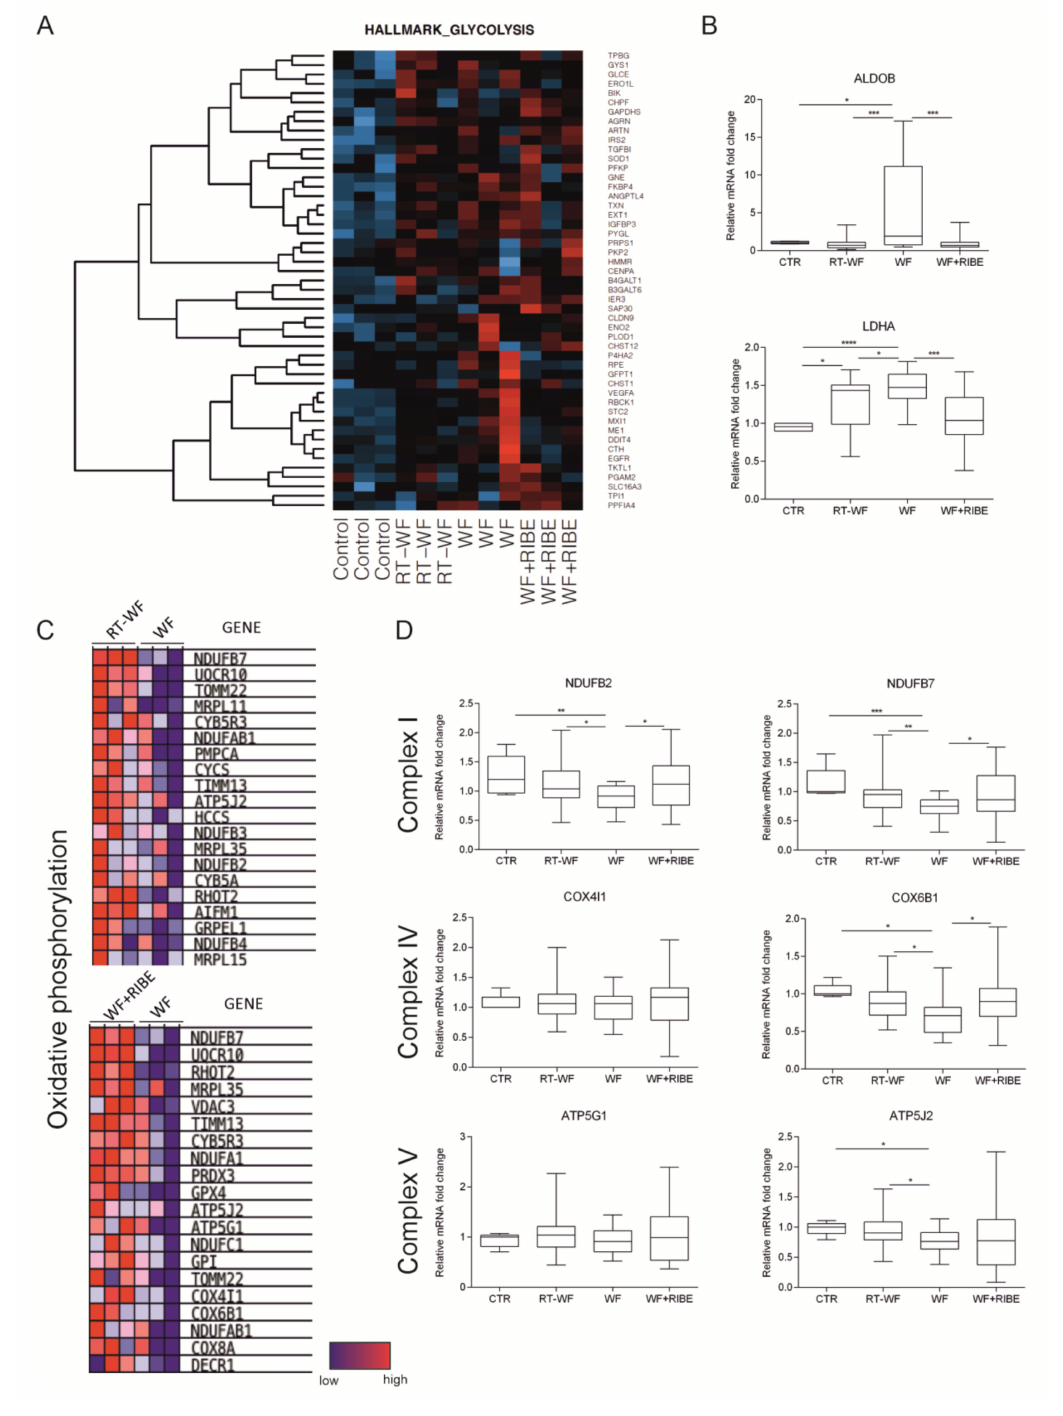
Figure 4. Surgical wound fluids a ff ect the metabolism of the MDA-MB-468 cell line. Microarray analysis revealed that MDA-MB-468 cells treated with RT-WF, WF, or WF + RIBE fluids are significantly enriched in glycolytic metabolism compared to untreated cells (controls) ( A ). This enriched glycolysis was confirmed by RT-qPCR analysis ( B ). However, microarray data from comparisons (RT-WF vs. WF and WF + RIBE vs. WF) indicate that MDA-MB-468 cells treated with RT-WF or WF + RIBE are characterized by enhanced oxidative phosphorylation ( C ). Those results were confirmed by RT-qPCR analysis ( D ). The qPCR reaction was performed the following samples: RT-WF ( n = 22), WF ( n = 21), WF + RIBE ( n = 21), and controls ( n = 8). The graphs represent relative mRNA fold changes ± standard deviation. * p < 0.05; ** p < 0.01; *** p < 0.001, **** p <